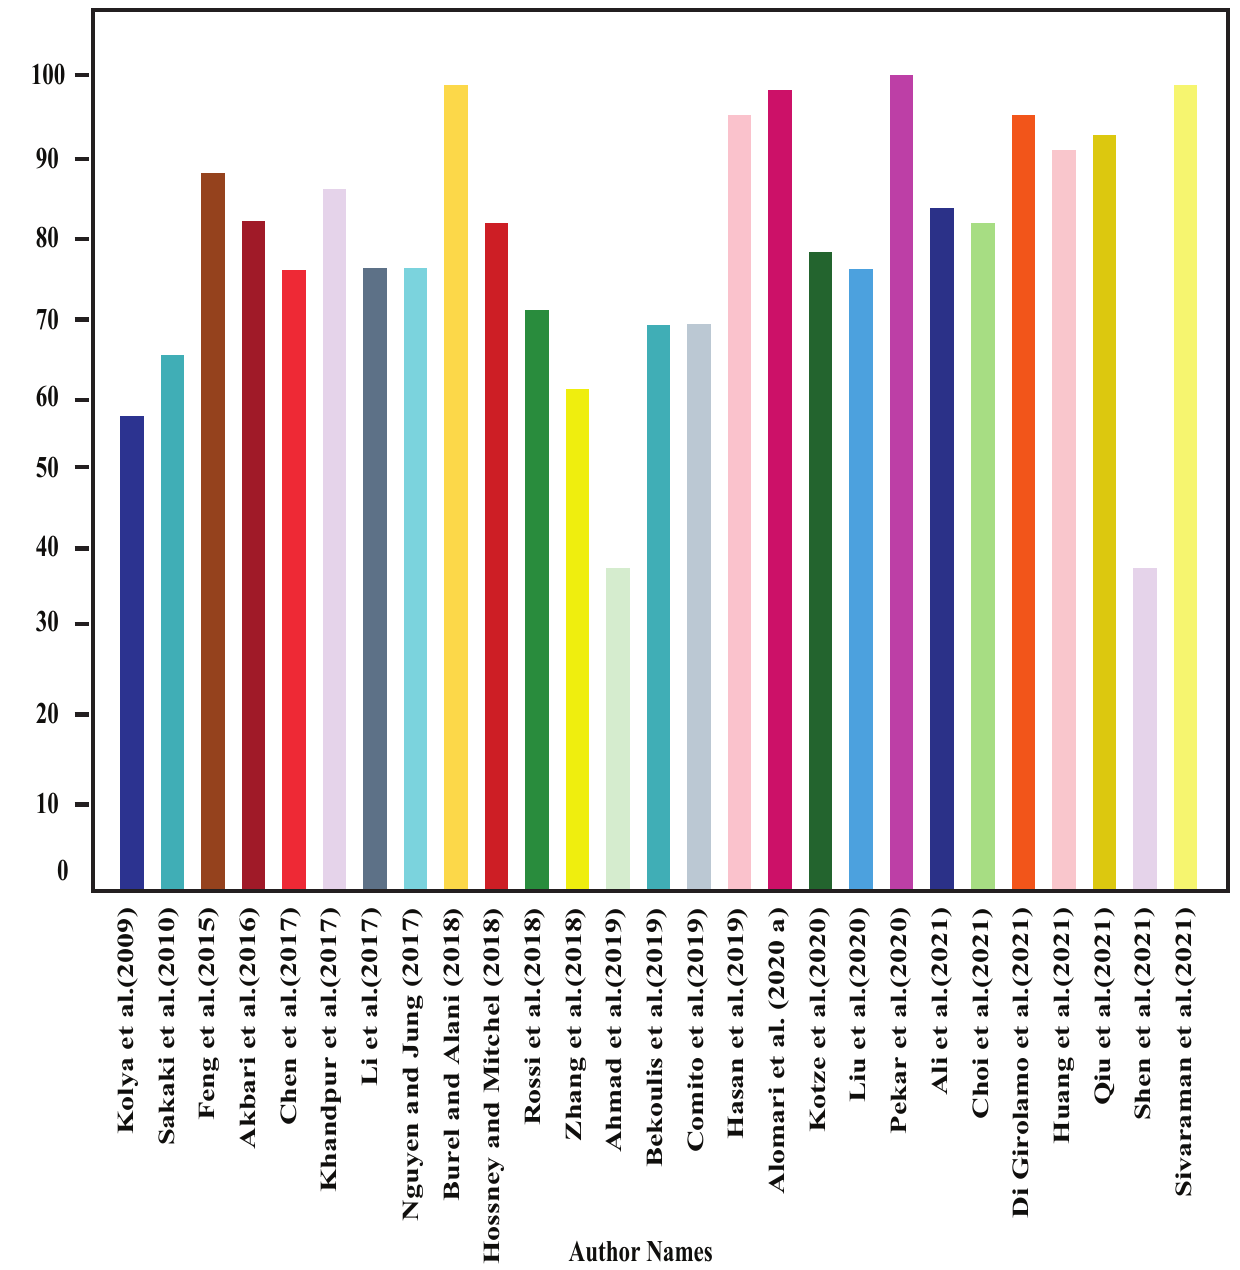
Figure 6. Recall-based performance comparisons of the articles. The height of each bar presents an article’s recall, which is given in the Y-axis, and the X-axis shows the author’s name. Refs. [19,20,32,33,36,45,47,53,55,59,62–67,69,70,73,75,79,83,94,97,103,106,107] have used recall for their performance analysis, and their values are presented using the bars in this